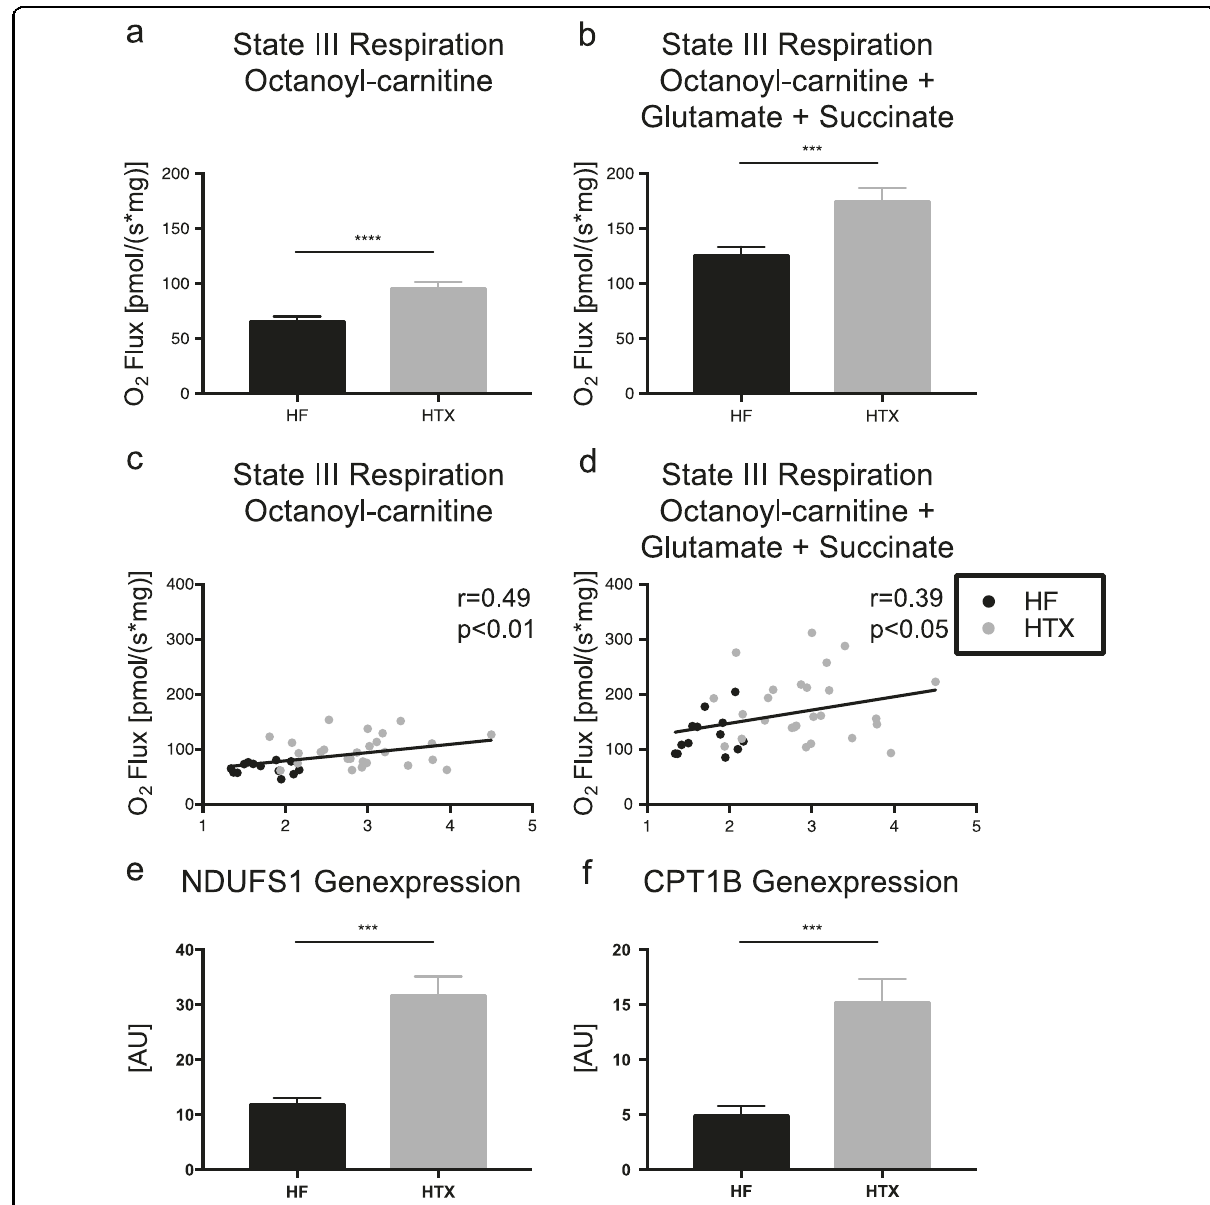
Fig. 4 State III myocardial respiration on octanoyl-carnitine ( a , c ) and on the citrate cycle-derived substrates glutamate and succinate ( b , d ) and mRNA expression of NDUFS1 and CPT1B in myocardial tissue specimens from patients suffering from terminal heart failure and heart transplant recipients. a , b Comparison of maximal myocardial respiration. Student's t -test. c , d Correlation of maximal myocardial respiration and cardiac index measurements. Spearman correlation. e , f Expression of NDUFS1 and CPT1B mRNA. Student's t -test. n = 40 (HF, patients suffering from terminal heart failure; n = 4 in mRNA measurements), n = 29 (HTX, heart transplant recipients; n = 21 in mRNA measurements). AU arbitrary unit. *** p <